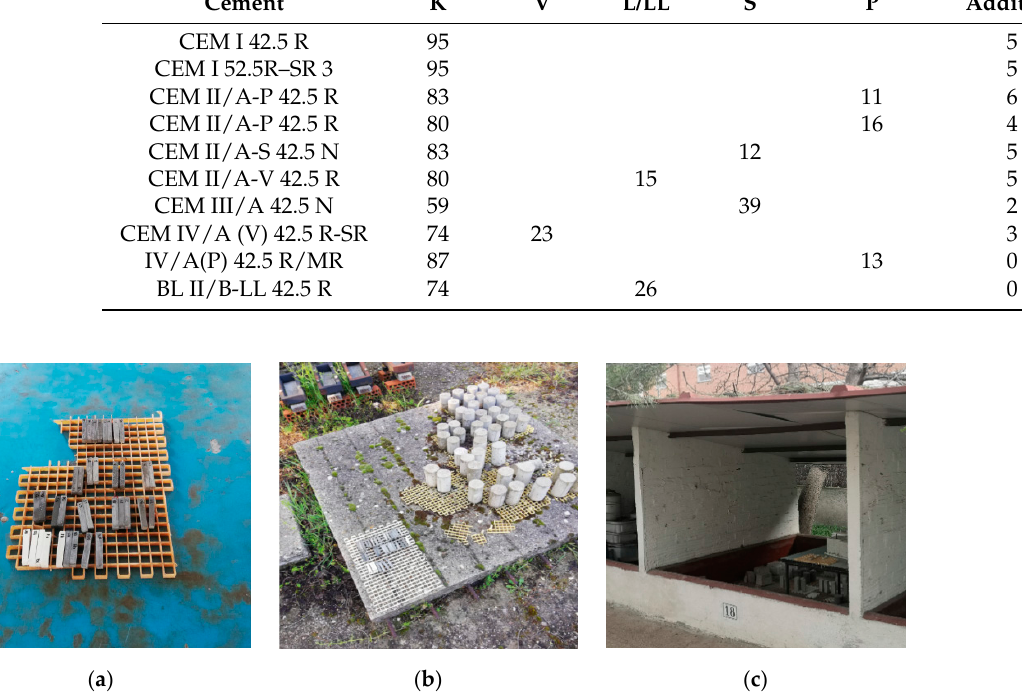
Figure 2. Exposure to natural carbonation: environments: ( a ) indoor (laboratory) environment, ( b ) outdoor unsheltered environment and ( c ) outdoor sheltered environment.